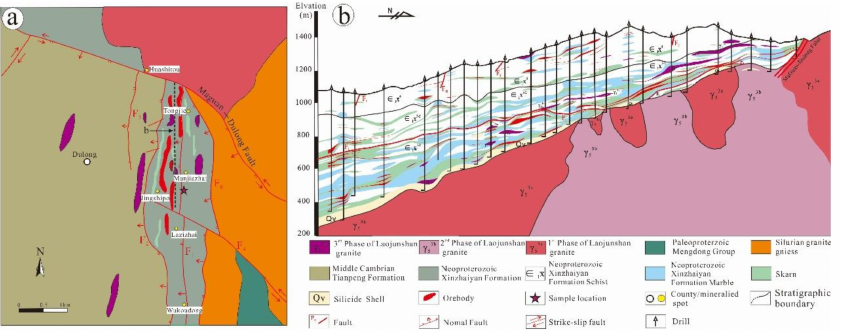
Figure 2. ( a ) Geological map of the Dulong Sn-Zn polymetallic skarn deposit [22]. ( b ) S–N cross section from the Lazizhai ore block (S) to the Tongjie ore block (N), modified after (geological data from Yunnan Hualian Mineral Exploration Co. Ltd., 2016; Qujing,